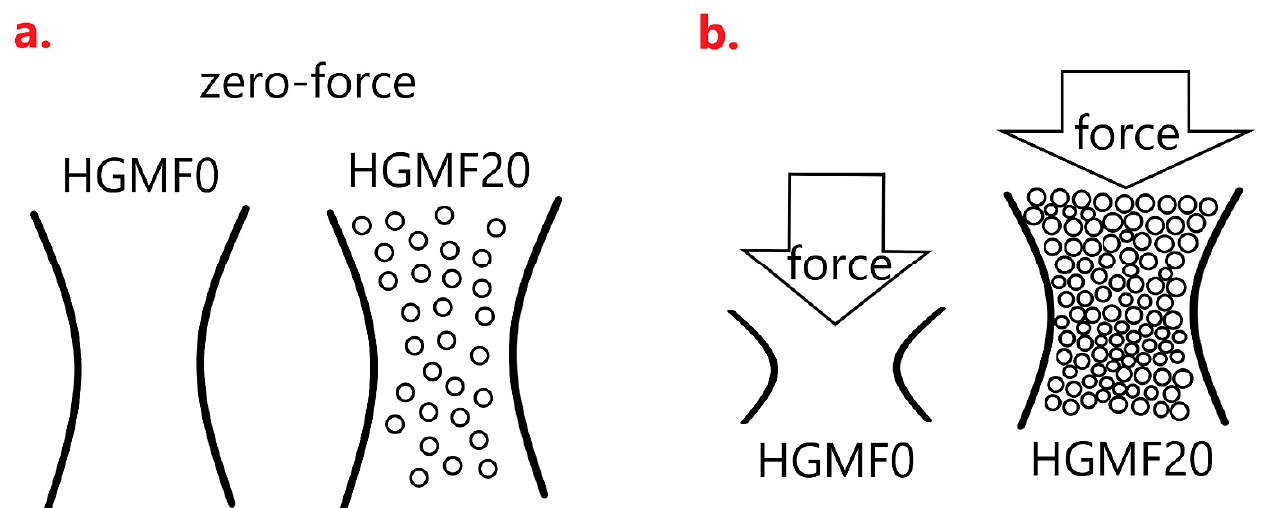
Figure 10. The difference in cell wall whether a compression force is exerted. ( a , b ) shows the schematic diagram of samples before and after stress force loading.